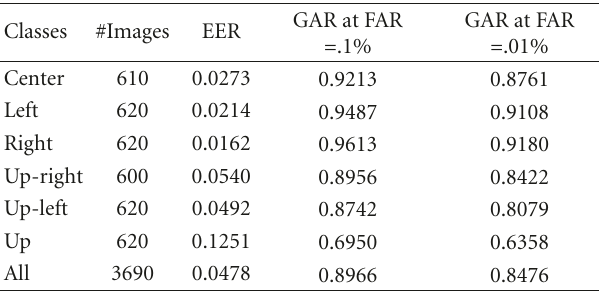
Table 4: Recognition results of the proposed method for same eyes divided into classes based on angle of